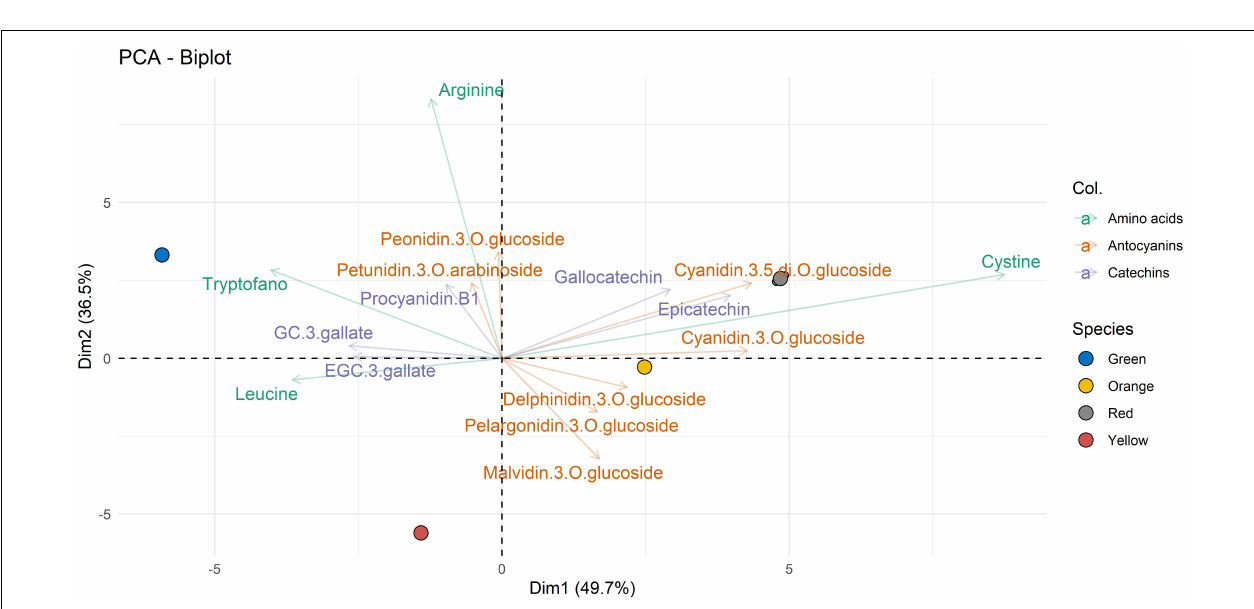
FIGURE 2 | MRM chromatograms of glutamic acid (A) and malvidin-3-O-glucoside (B) standard molecules. The best transitions 148 m/z → 130 m/z, 148 m/z → 102 m/z and 148 m/z → 84 m/z and 493 m/z → 331 m/z and 493 m/z → 270 m/z were monitored for glutamic acid and malvidin-3-O-glucoside, respectively. Analytical parameters calculated for the standards (LOD, LOQ), angular coefficient (m), y-intercept (q), and R 2 are reported.